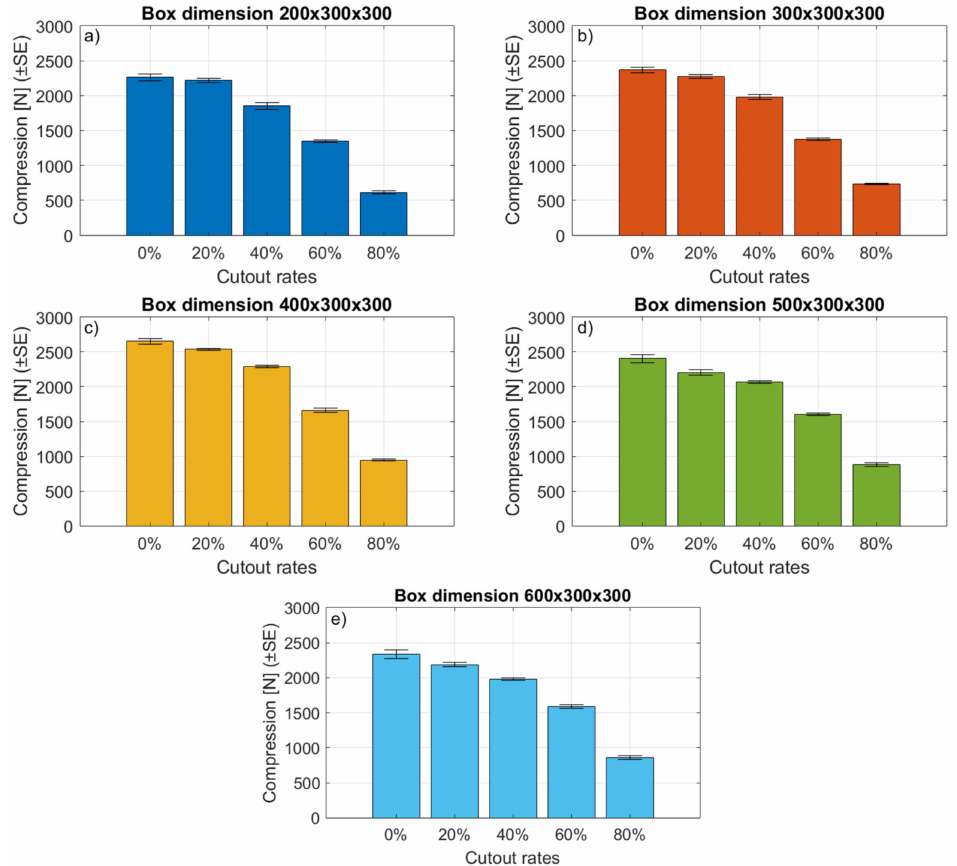
Figure 8. Averages of maximum compression forces and its standard errors (SE): ( a ) 200 × 300 × 300 mm box; ( b ) 300 × 300 × 300 mm box; ( c ) 400 × 300 × 300 mm box; ( d ) 500 × 300 × 300 mm box; ( e ) 600 × 300 × 300 mm